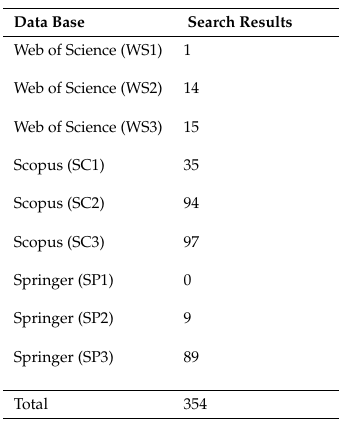
Table 2. Preliminary paper results per database.